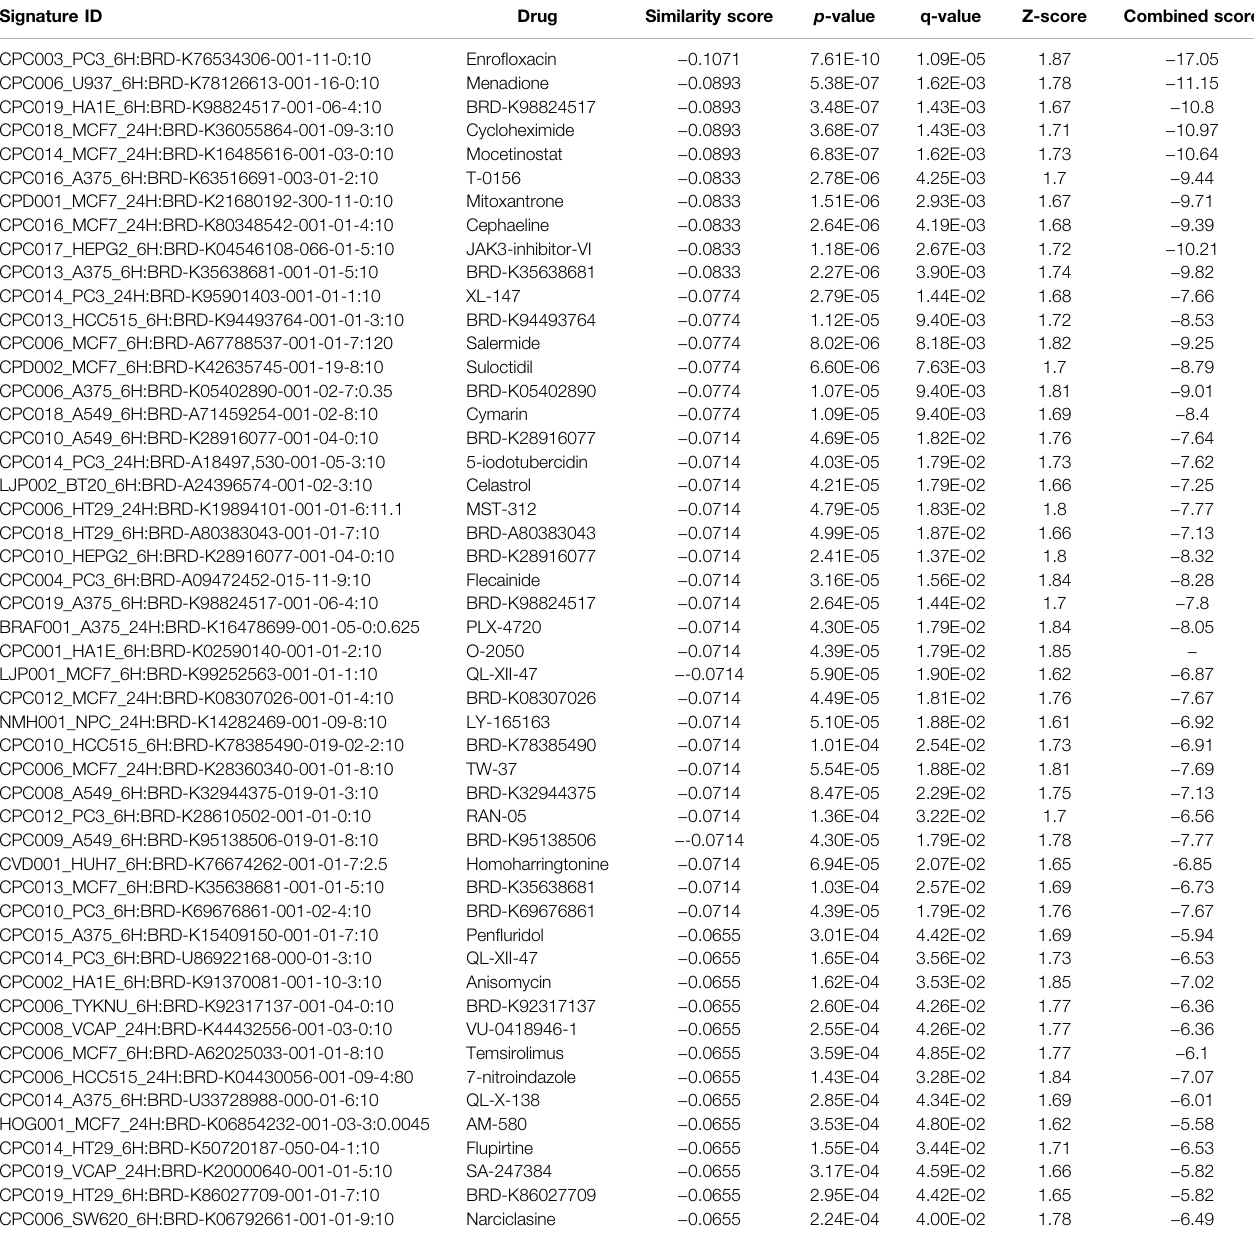
TABLE9| Thetop50drugsornaturalproductsthatreverseDEGsofastrocytesfromentorhinalcortexinAD(AD00205(disease)vsAD00201(control)basedonL1000FWD